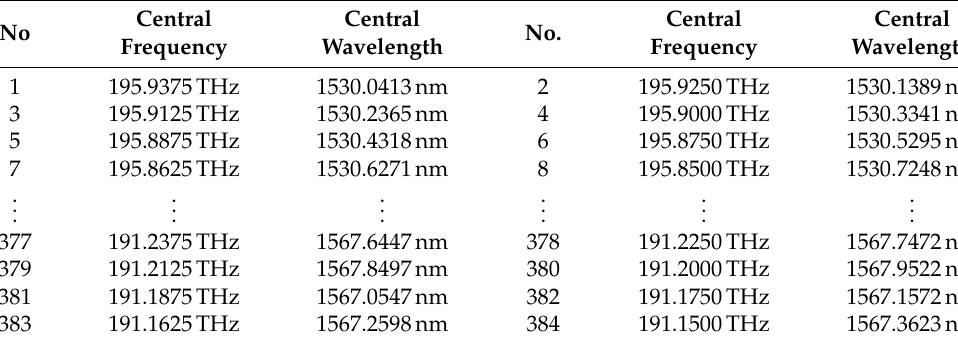
Table 2. Nominal central frequencies with 12.5GHz spacing [31,32].